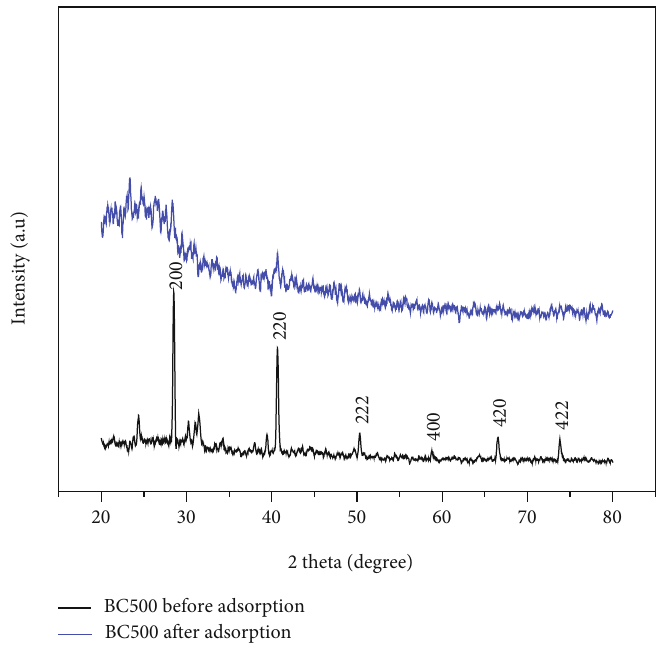
Figure 8: The XRD spectra of BC500 before and after MB adsorption.